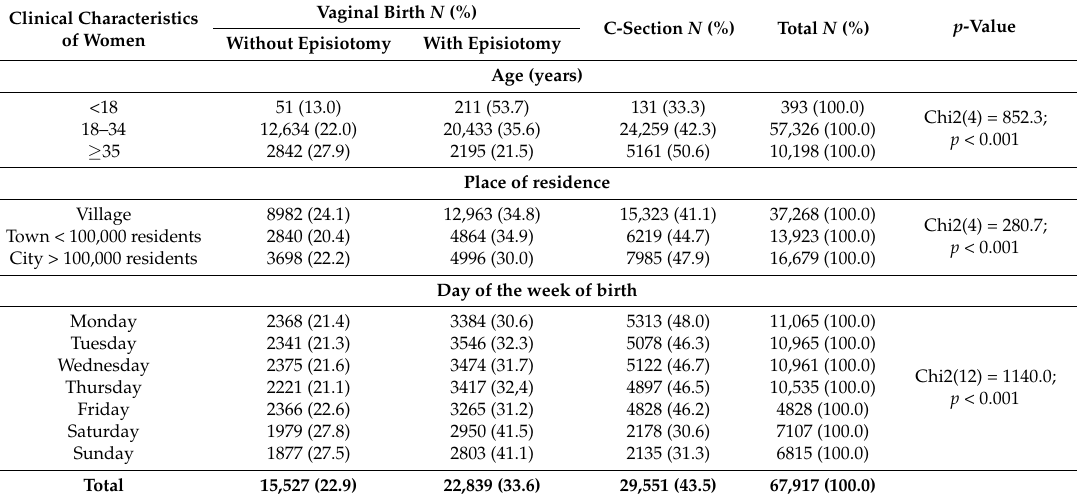
Table 2. Type of birth in women giving birth in the years 2013–2014 in Malopolska considering their age, place of residence, and day of the week of